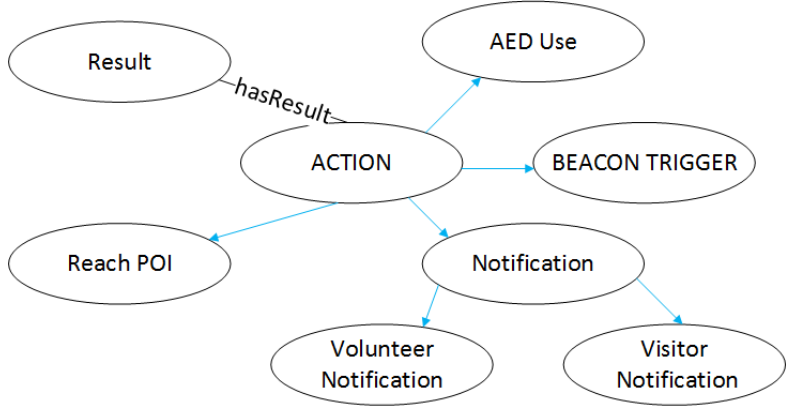
Figure 9. Action